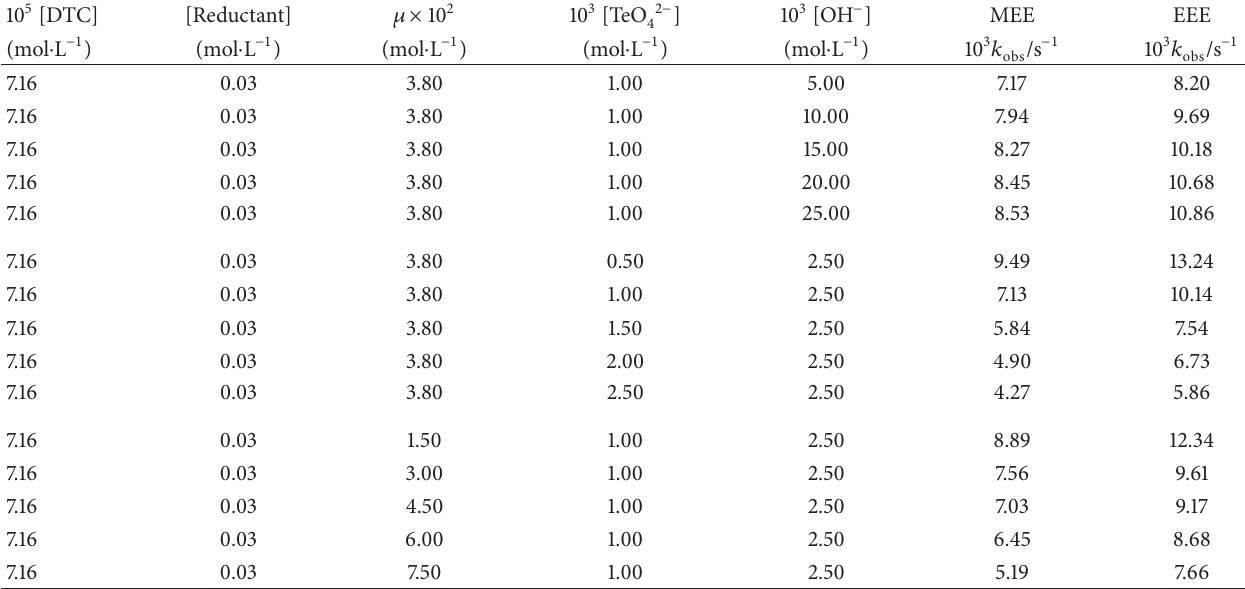
Table 3: Effect of [OH − ], [TeO 42− ], and 𝜇 on the reaction at 298.2 K. 10 5 [DTC]